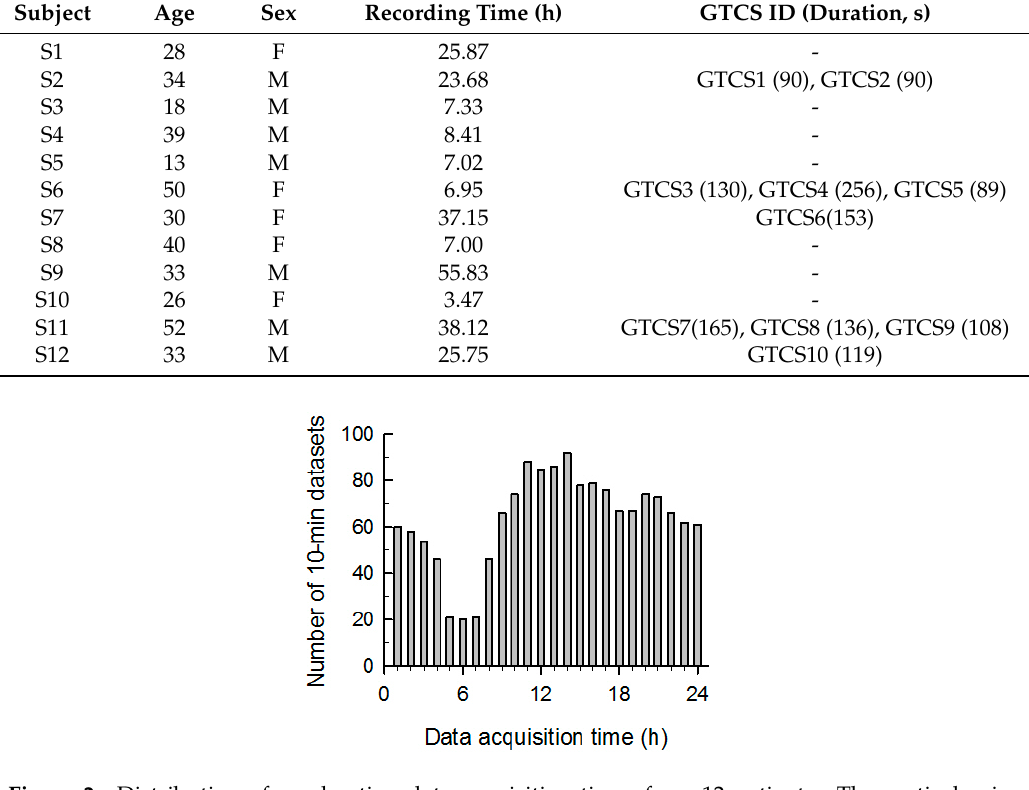
Figure 2. Distribution of acceleration data acquisition times from 12 patients. The vertical axis represents the number of 10-min datasets recorded during an hour interval.